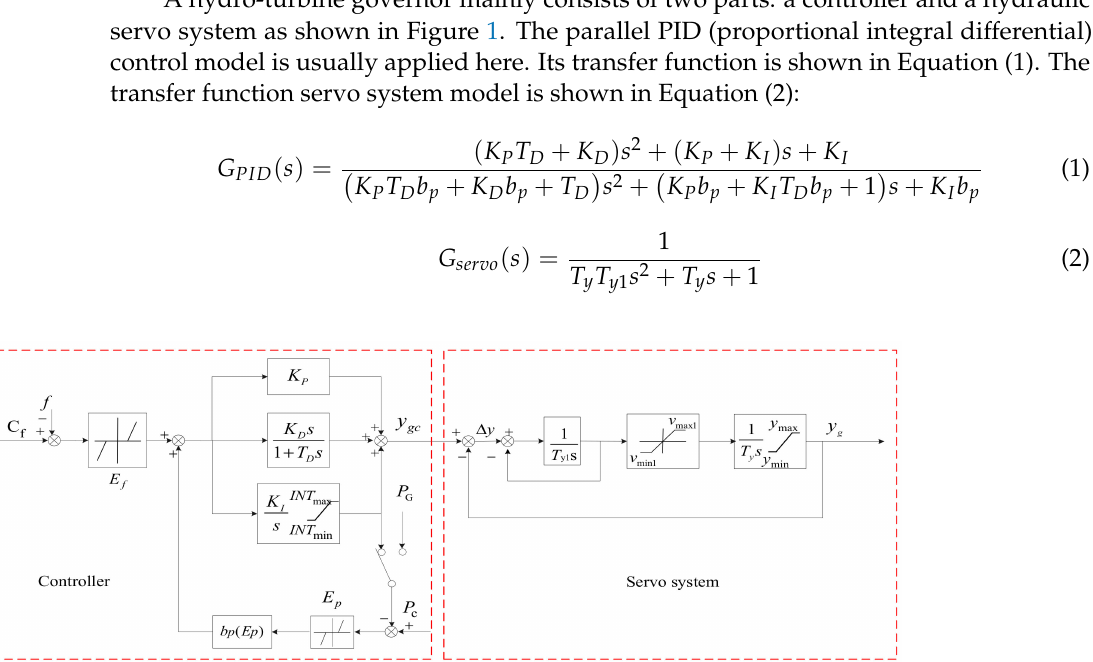
Figure 1. Structure of the mathematical model of the hydro-turbine